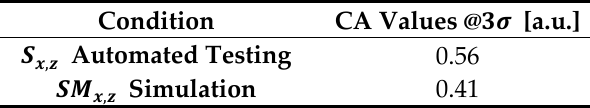
Figure 3. Scatter plot of data coming from automated testing equipment which points out the correlation between S x,z and Y-Quadrature (blue dots) and sample CA simulation results for the considered case (red dots). Table 1. Simulation and testing result